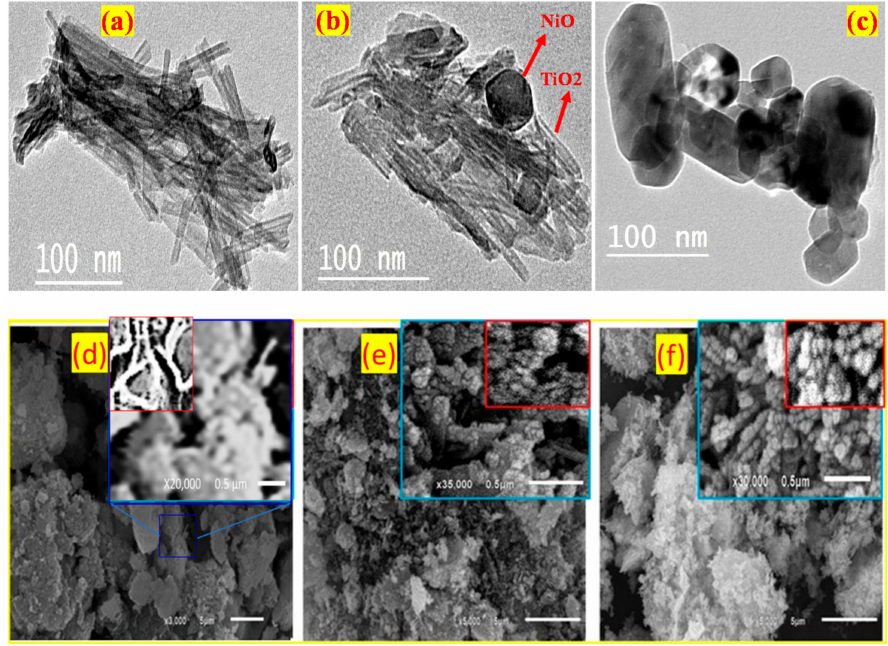
Figure 2. TEM images of the fabricated ( a ) TiO 2 NTs, ( b ) TiO 2 /2NiO, and ( c ) NiO NPs, and SEM images of the fabricated ( d ) TiO 2 NTs, ( e ) TiO 2 /2NiO, and ( f ) NiO